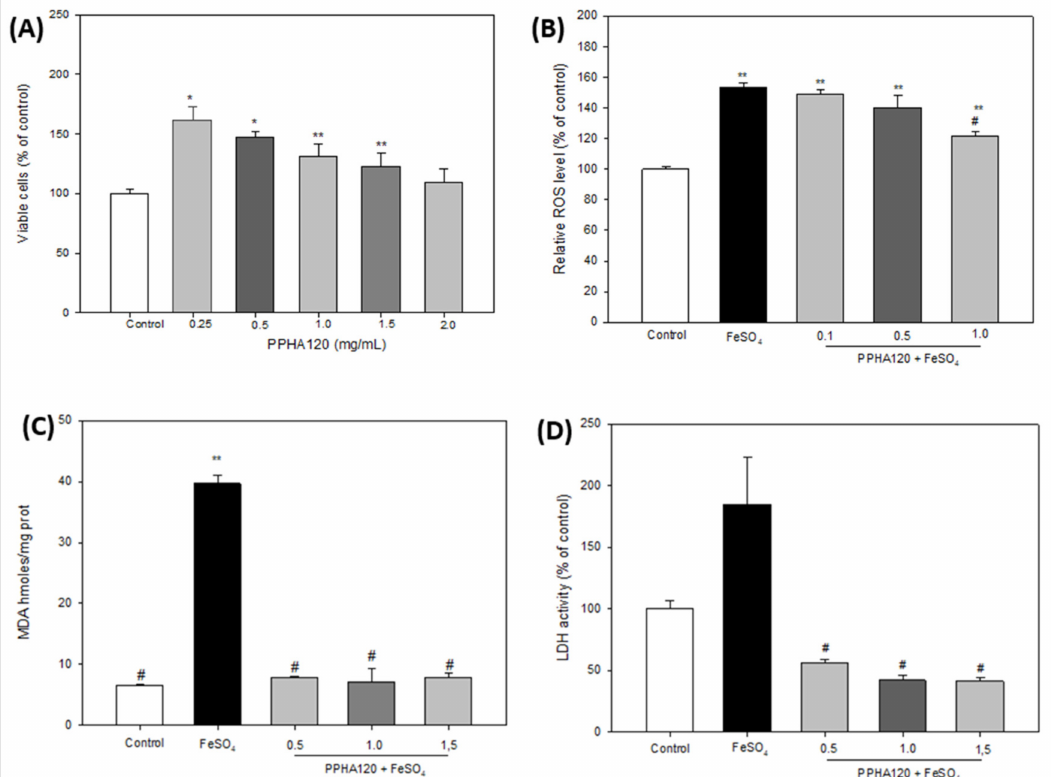
Figure 4. ( A ) Viable SH-SY5Y cells (% of control) after their treatment with the pajuro albumin hydrolyzate PPHA120 at different concentrations (0.25–2 mg/mL). ( B ) ROS levels (% of control) after the treatment of SH-SY5Y cells with FeSO 4 in the absence and presence of PPHA120 at different concentrations (0.1–1.0 mg/mL). ( C ) MDA levels (nmoles/mg protein) after the treatment of SH-SY5Y cells with FeSO 4 in the absence and presence of PPHA120 at different concentrations (0.5–1.5 mg/mL). ( D ) LDH activity (% of control) after the treatment of SH-SY5Y cells with FeSO 4 in the absence and presence of PPHA120 at different concentrations (0.5–1.5 mg/mL). * p < 0.05 or ** p < 0.001 vs. control (non-treated cells), # p < 0.001 vs. FeSO 4 -treated